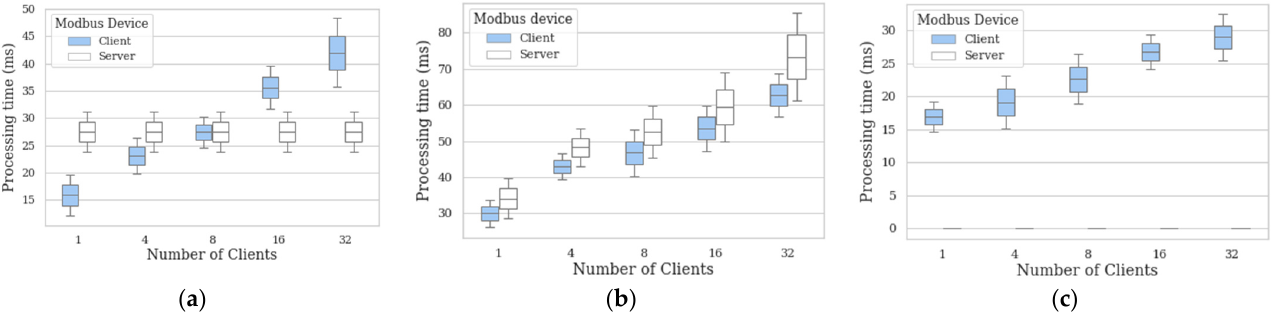
Figure 5. Processing time of ( a ) registration phase; ( b ) channel securing phase; ( c ) verification phase.